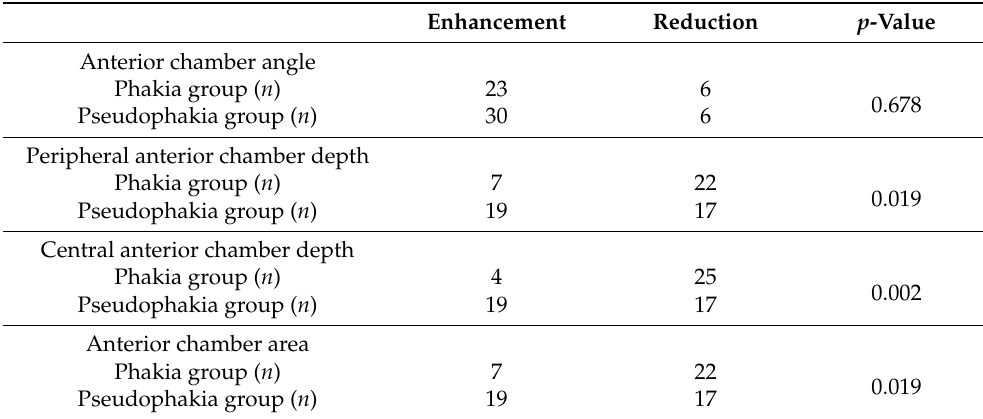
Pearson chi-squared